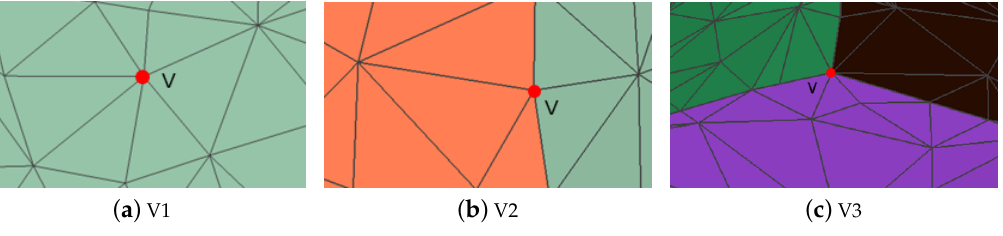
Figure 7. Types of vertices. ( a ) Vertices belong to one region. ( b ) Vertices belong to two regions. ( c ) Vertices belong to three regions.